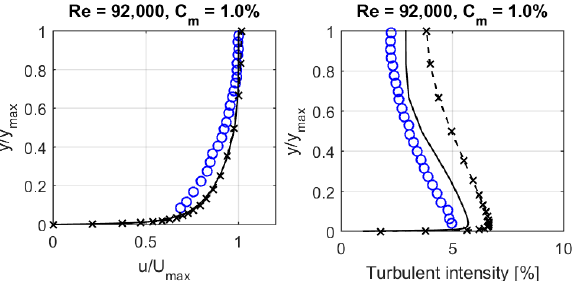
Figure 9. Normalised velocity profiles ( left ) and turbulent intensity profiles ( right ) for fibre suspension consistency 1% and Reynolds number 92,000 for the Bingham model ( − ), the ODF model (-- × ) and the experiments (o) from Xu and Aidun (2005) [27].